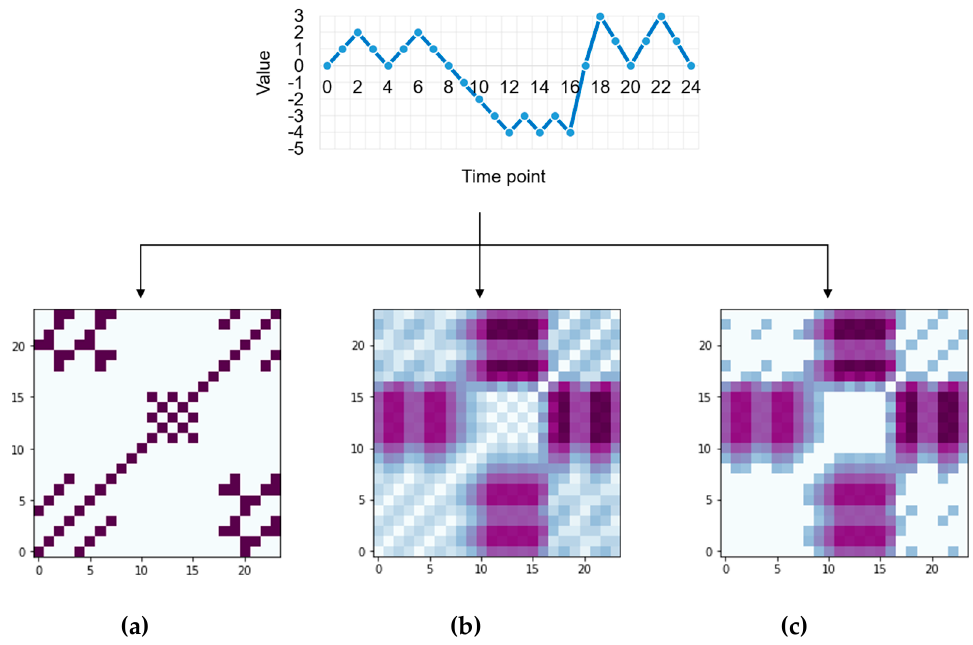
Figure 3. An illustrative example of recurrence patterns (RP): ( a ) Bin-RP; ( b ) Cont-RP; ( c ) ReLU-RP.